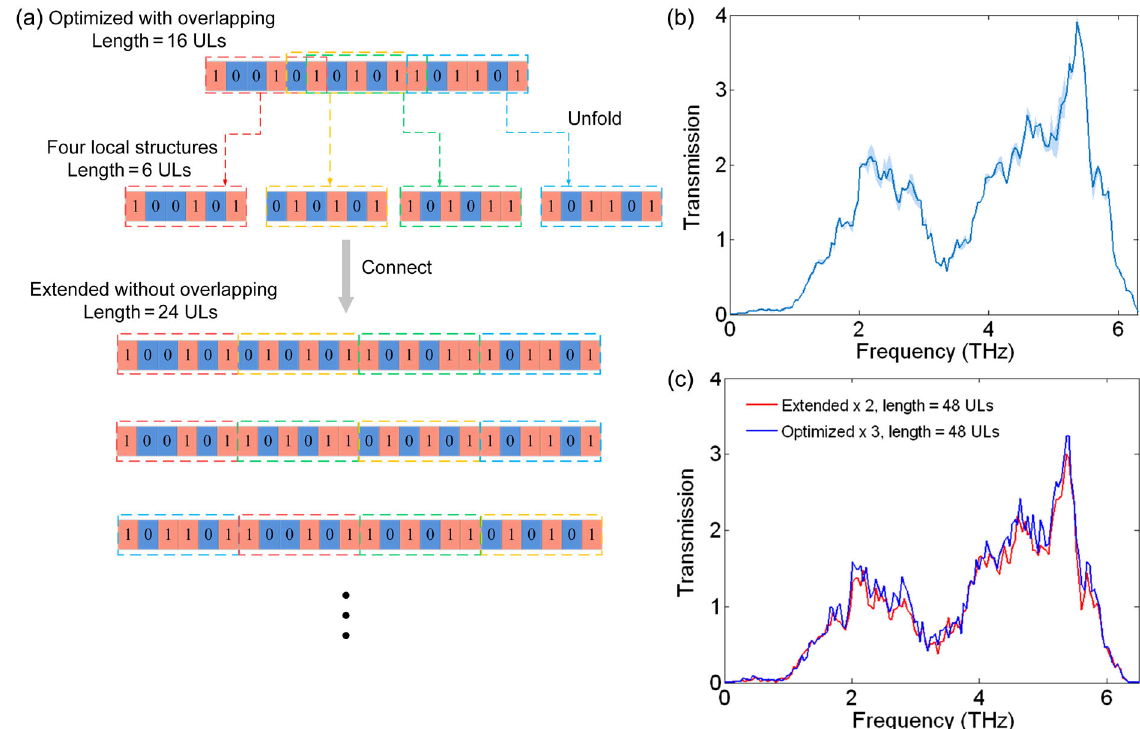
FIG. 6. Local structure independence and correlation examination. (a) Schematic for the optimized SL (16-ULs) and the extended SL (24-ULs). (b) Averaged phonon transmission of the 24 extended SLs, i.e., all possible sequences when serially connecting the four key local structures 101010, 110101, 101001, and 101101. The shadowed region denotes the standard deviation. (c) Comparison of phonon transmissions of optimized SL and the extended SL (averaged) made to the same lengths (48ULs) by repeating three times and twice,